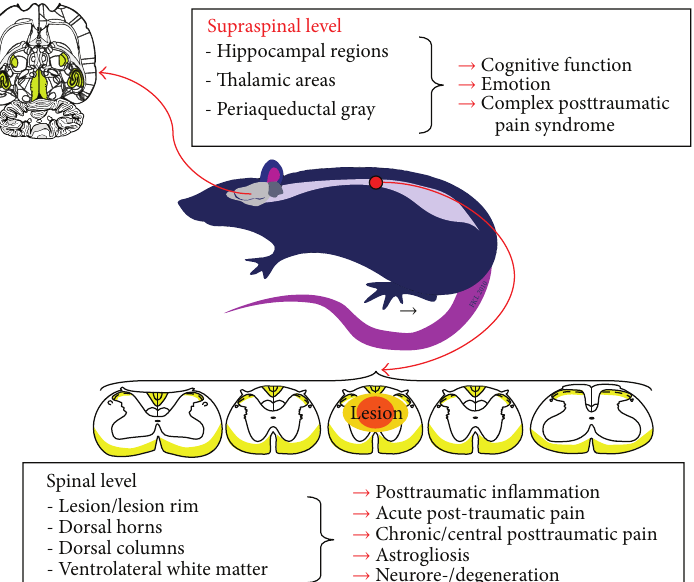
Figure 3: The chemokine-ligand/receptor-network is potentially involved in varied processes after SCI, making these mediators interesting targets for tailored therapeutic